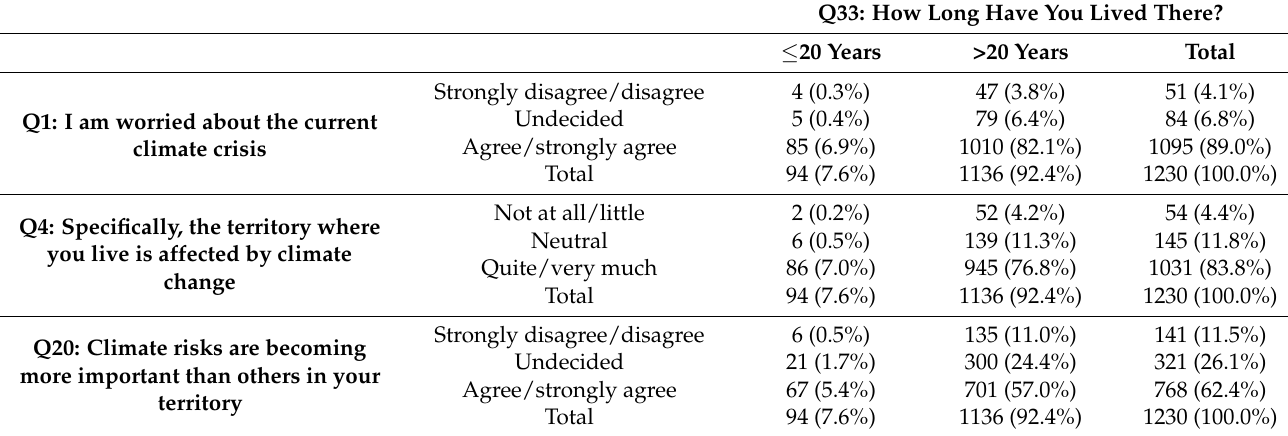
Q33: How Long Have You Lived There? ≤ 20 Years >20 Years